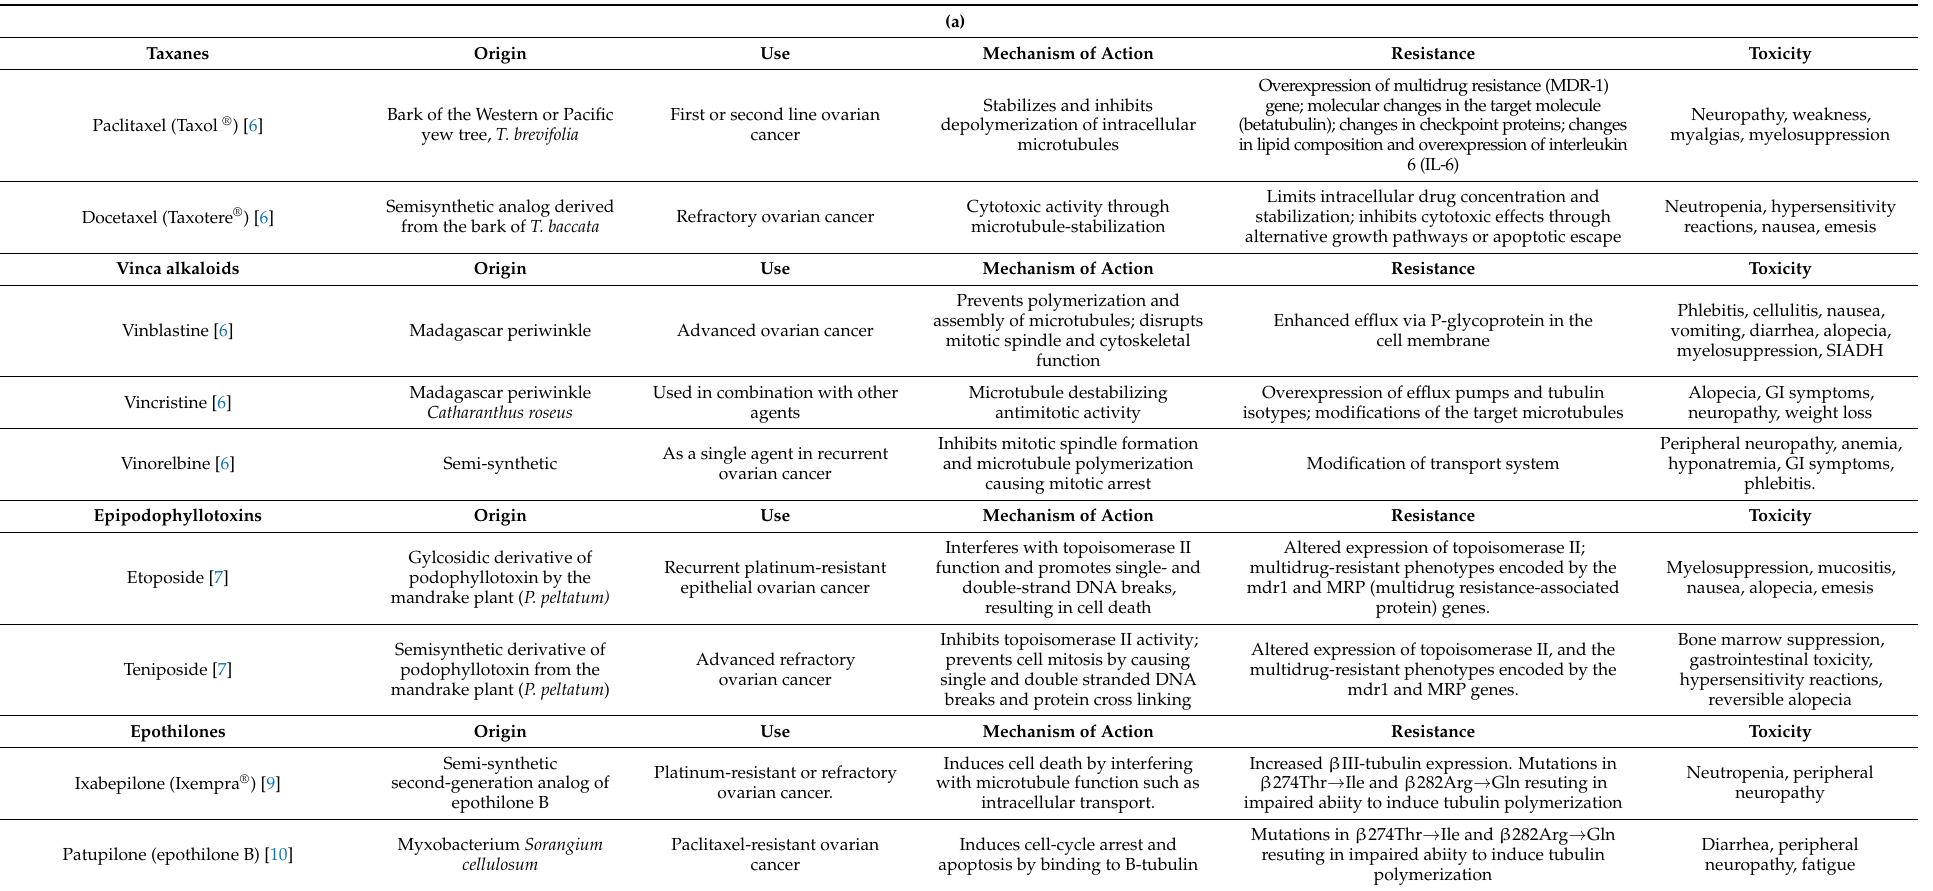
Table 1. ( a ) Microtubule-interfering cytotoxic agents used in the treatment of ovarian cancer. ( b ) Evidence for microtubule-interfering cytotoxic agents used in frontline and recurrence treatment of ovarian